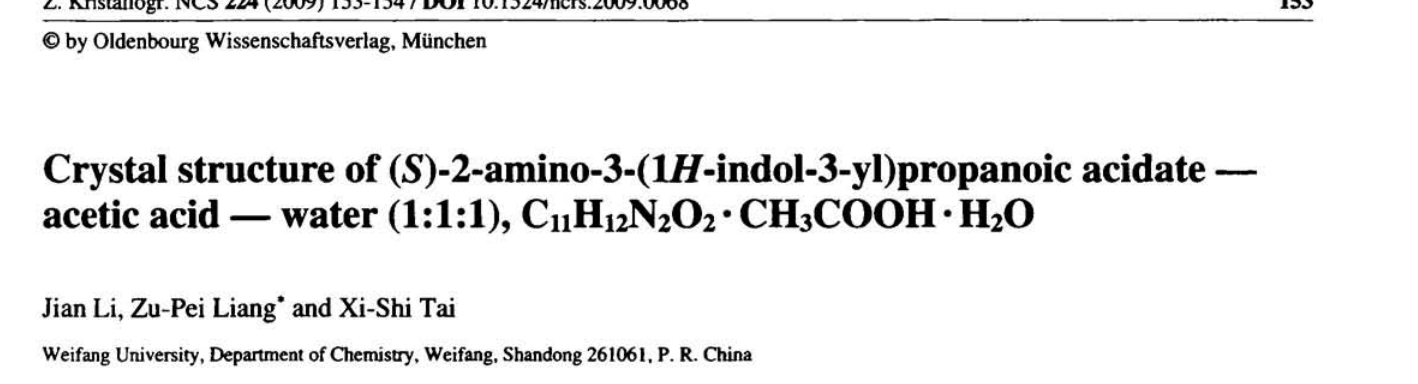
Table 1. Data collection and handling. Crystal: Wavelength: